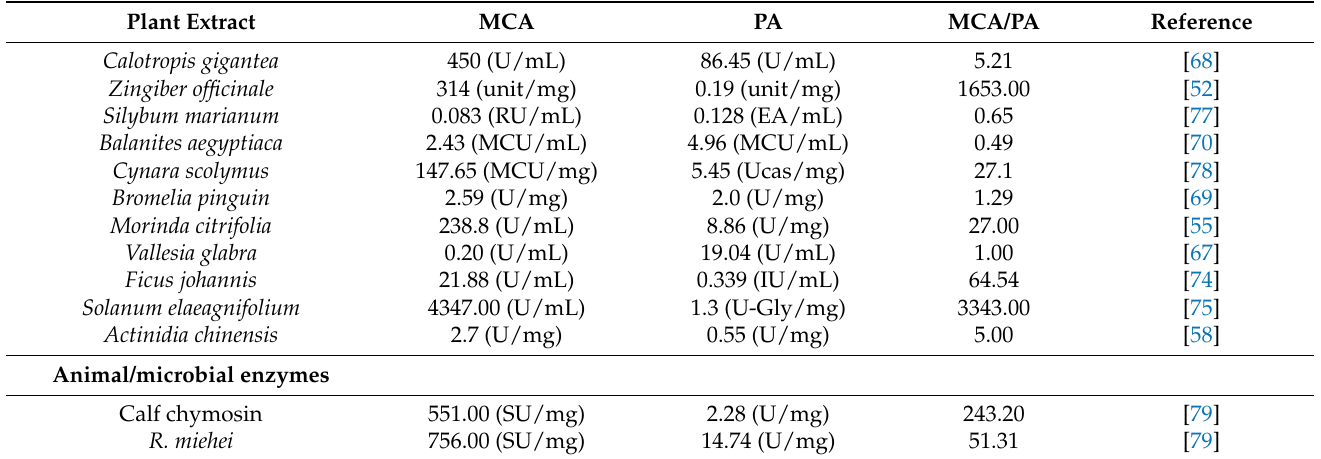
Table 2. Milk-clotting activity (MCA), proteolytic activity (PA), and MCA/PA ratio of plant extracts and other